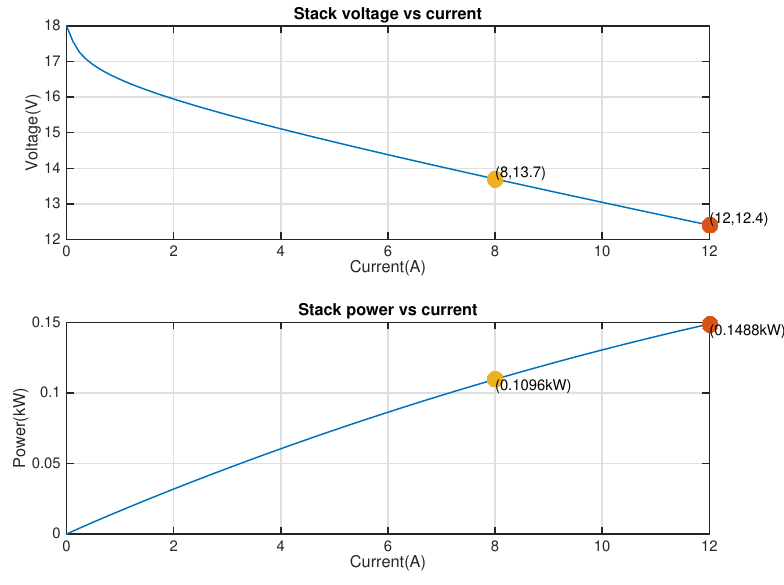
Figure 18. Polarization curve of the FC for semi-active